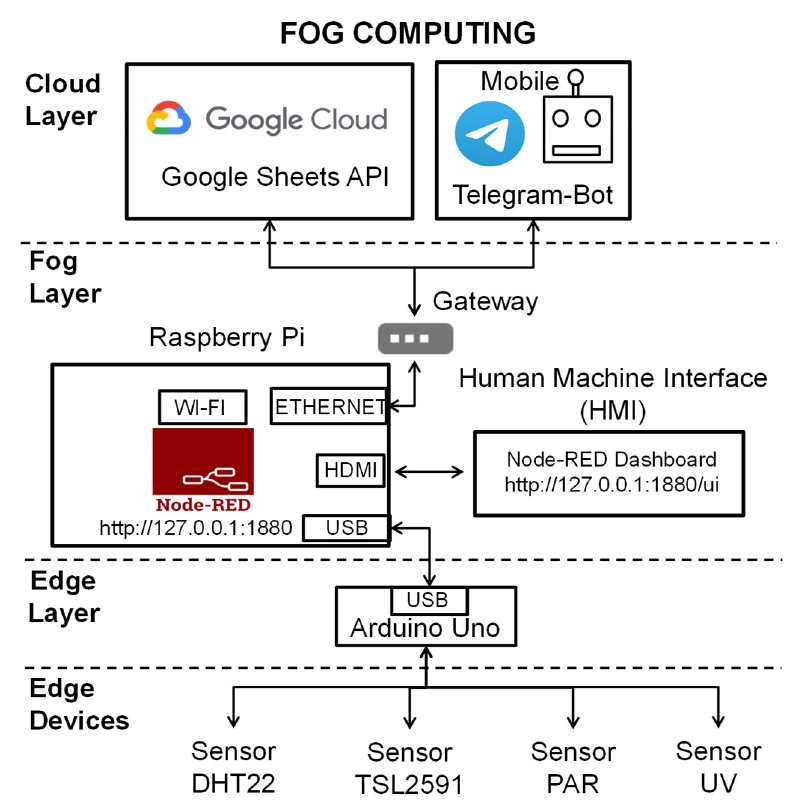
Figure 1. Simplified diagram of the proposed system.